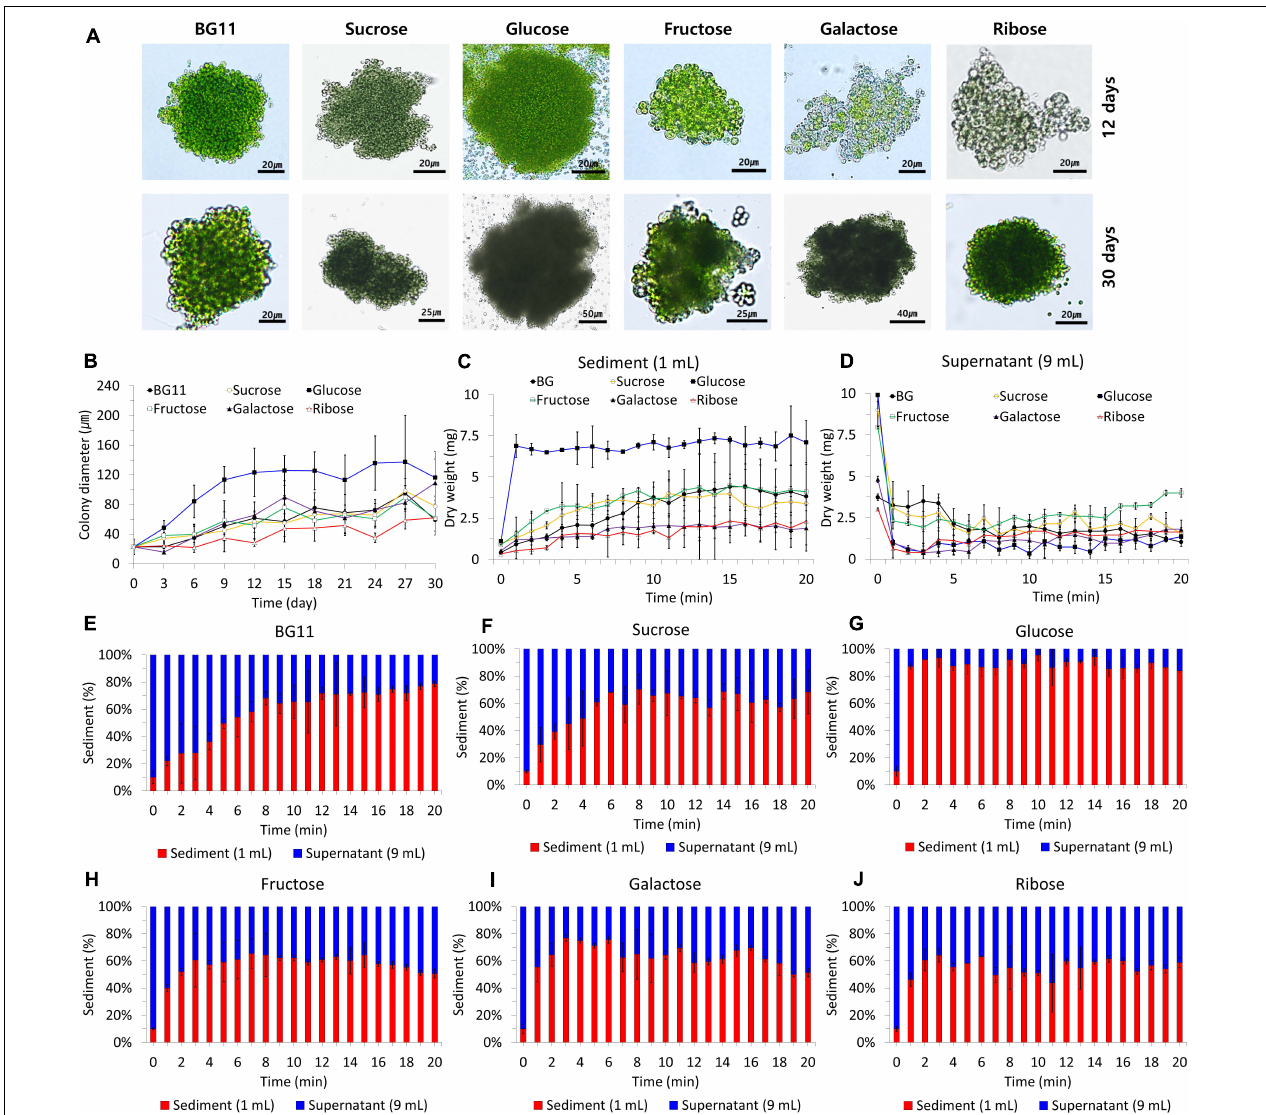
FIGURE 4 | B. sudetica KNUA107 colonies (A) and their size recorded in each culture condition during the culture process (B) . Settleability of B. sudetica KNUA107 cultured under each condition evaluated by the dry weight of the sediment (C) and the supernatant (D) . Sedimentation rate for photoautotrophic (BG11) (E) and mixotrophic conditions, including sucrose (F) , glucose (G) , fructose (H) , galactose (I) , and ribose (J) . The results are expressed as the ratio of the biomass, which is defined as